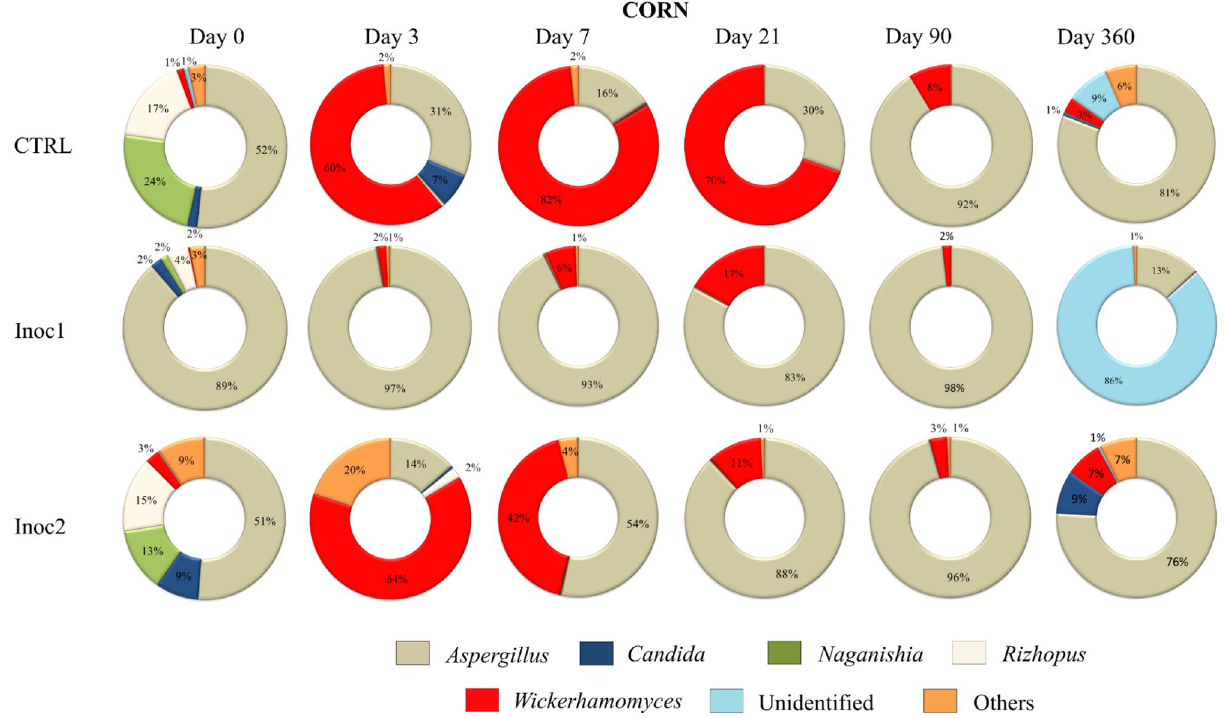
Figure 7. Main genera dynamics (%) of fungal communities of rehydrated corn grain silages after 0, 3, 7, 21, 90 and 360 days of fermentation. CTRL non-inoculated, Inoc1 Lactobacillus plantarum and Propionibacterium acidipropionici , Inoc2 Lactobacillus buchneri .